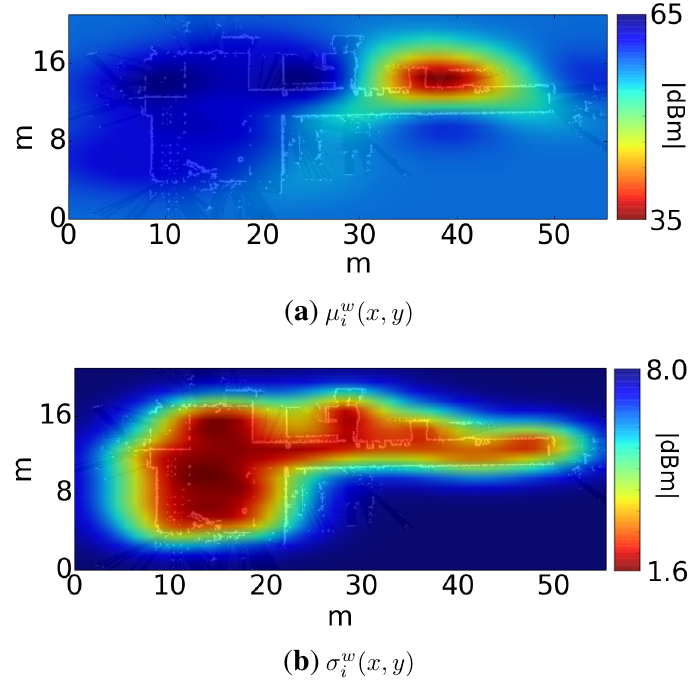
Figure 4. Output of the Gaussian process regression for a sample mote. ( a ) The lowest values (red) correspond to the highest power. It is clear that the APwas located near the position (40 m,16 m); ( b ) The lowest values (red) correspond to the lowest typical deviation